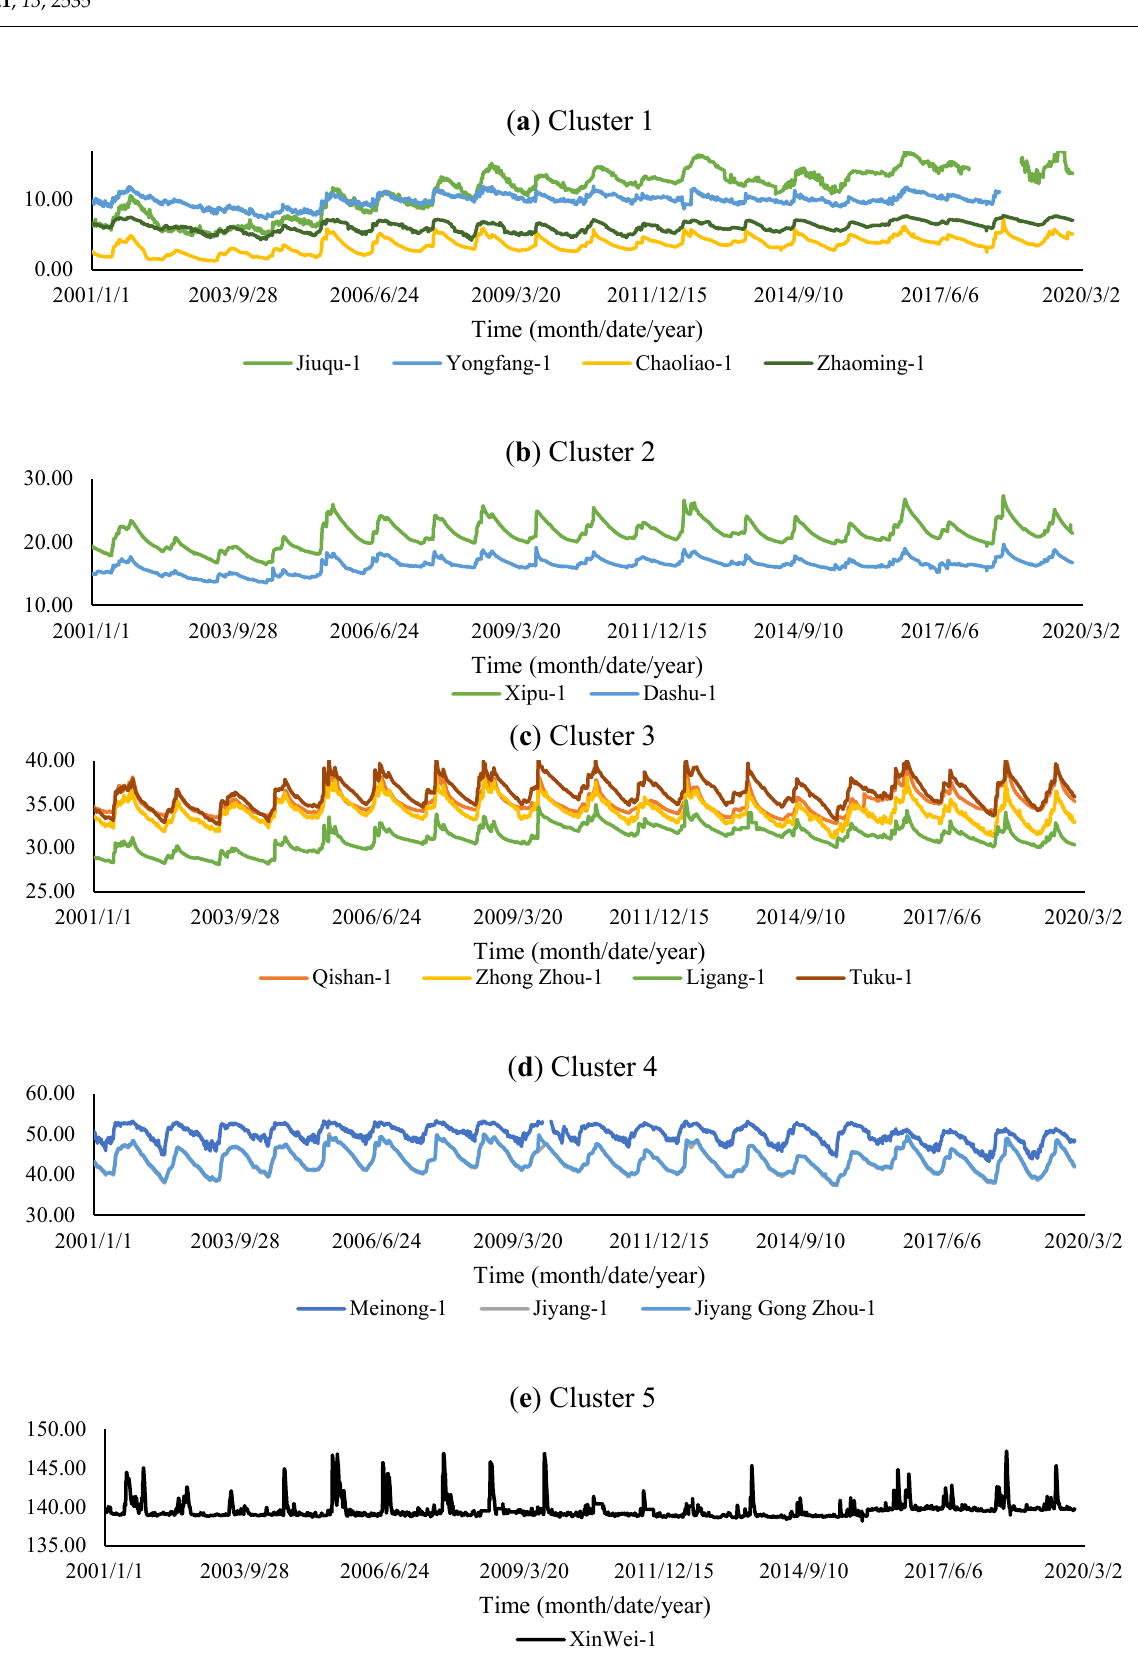
Figure 7. The spatial distribution of hierarchical clustering analysis.